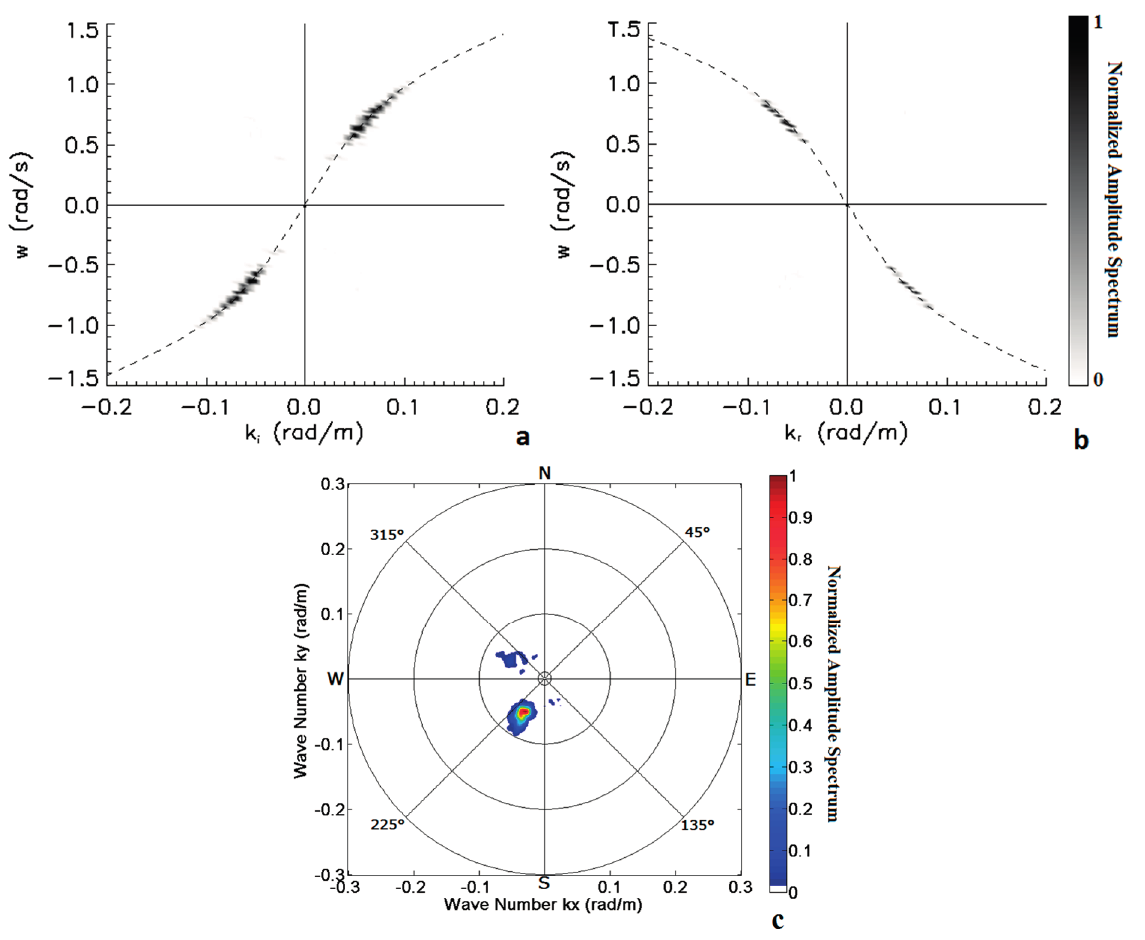
Figure 14. Two cuts of the 3D wave spectrum relative to the subarea B. (Panel a ): spectral components representative of the incident wave; (Panel b ): spectral components accounting for the reflected wave. The dashed lines represent the theoretical support of the sea waves; (Panel c ) 2D directional wave spectrum relative to the subarea